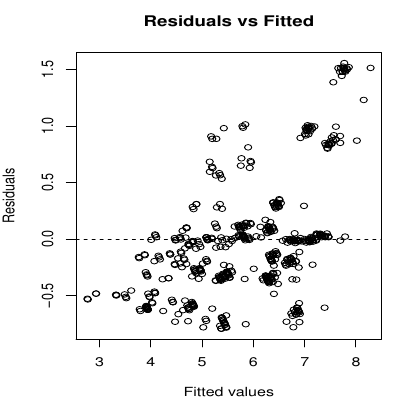
Figure 6. The residuals versus the estimated responses of the AR model.